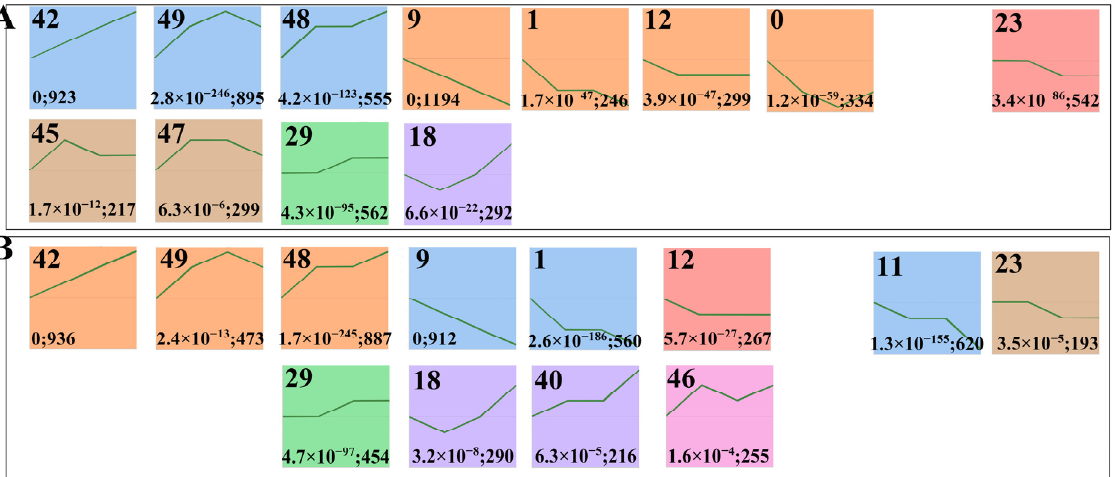
Figure 8. Clustering results of time course data from Hua30 ( A ) and A9 ‐ 29 ( B ) roots based on STEM analysis. Different model temporal expression profiles correspond to different boxes. The profile ID number is displayed in the top left corner of each box. The p ‐ value and gene numbers assigned to the profiles are shown at the bottom left corner of each box separated by a semicolon. The green curve represents a model expression pattern.